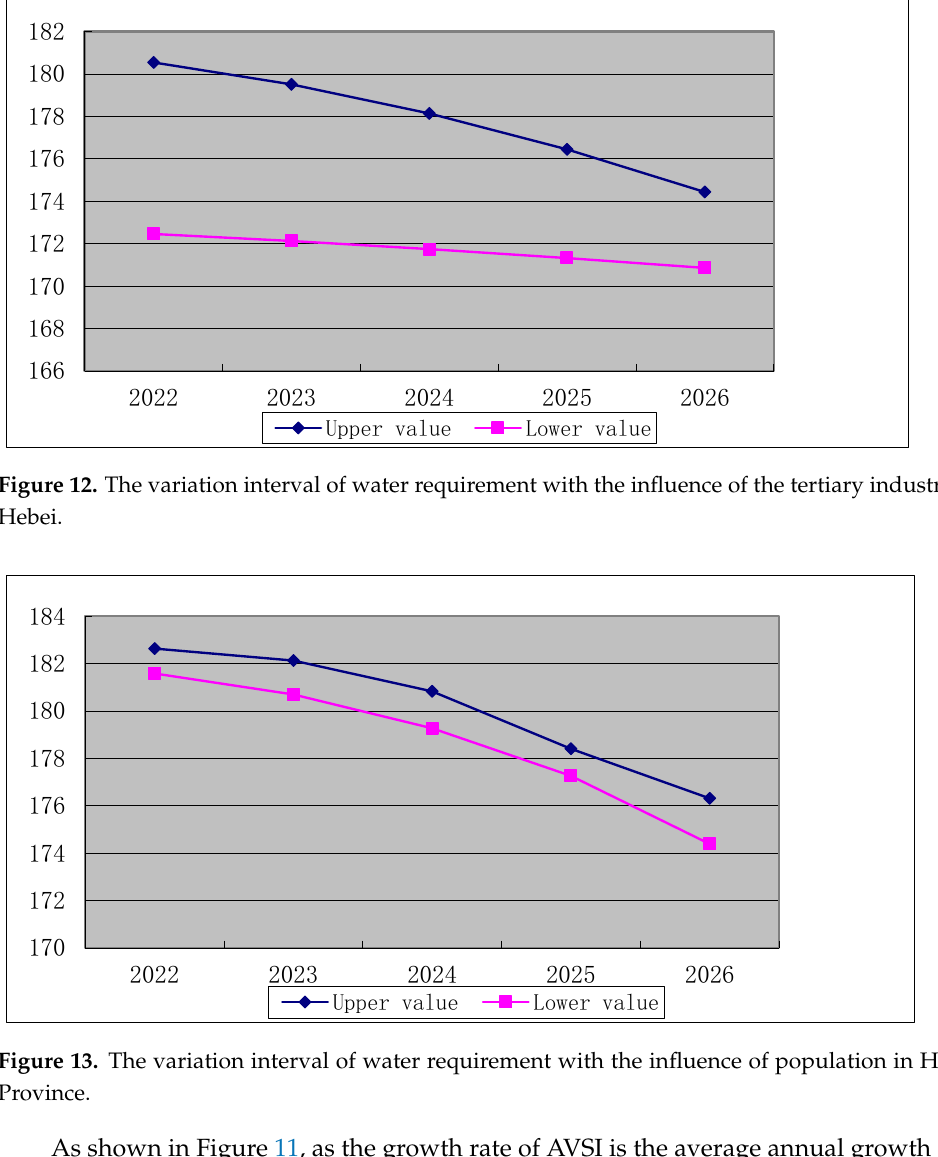
Figure 11. The variation interval of water requirement with the influence of the secondary industry in Hebei.